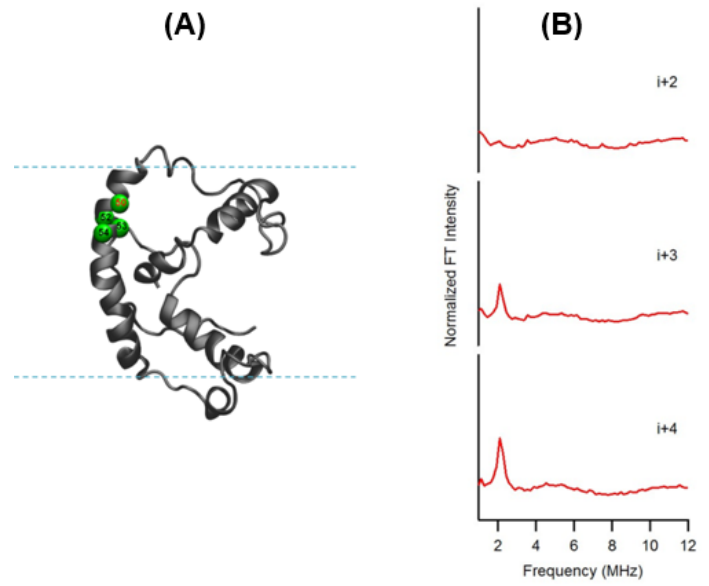
Figure 7. ( A ) Cartoon representation of KCNE1 in DMPC / dodecylphosphocholine (DPC) bicelles. The probed α -helical region is colored in green and located on the transmembrane domain of the full-length KCNE1. Residue 50 is side-chain 2 H-labeled Val (denoted i), Residues 52, 53, and 54 are independent Cys mutations (denoted i + 2 , i + 3 , and i + 4 , respectively). ( B ) Frequency domain spectra of three-pulse ESEEM data of i + 2 , i + 3 , and i + 4 samples shown in normalized FT intensity. (Adapted from [100] with